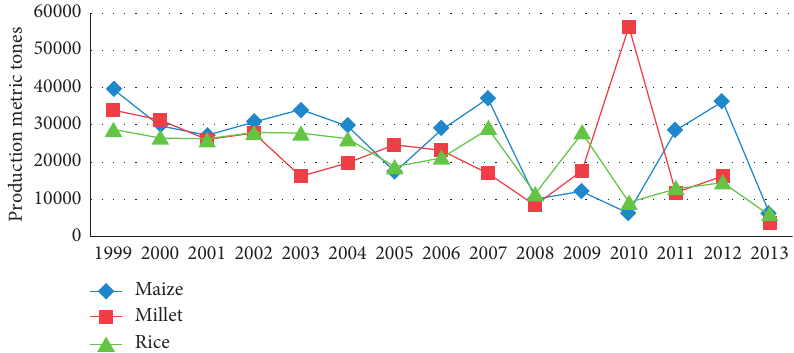
Figure 9: Major food crop production in the Bawku Municipality.